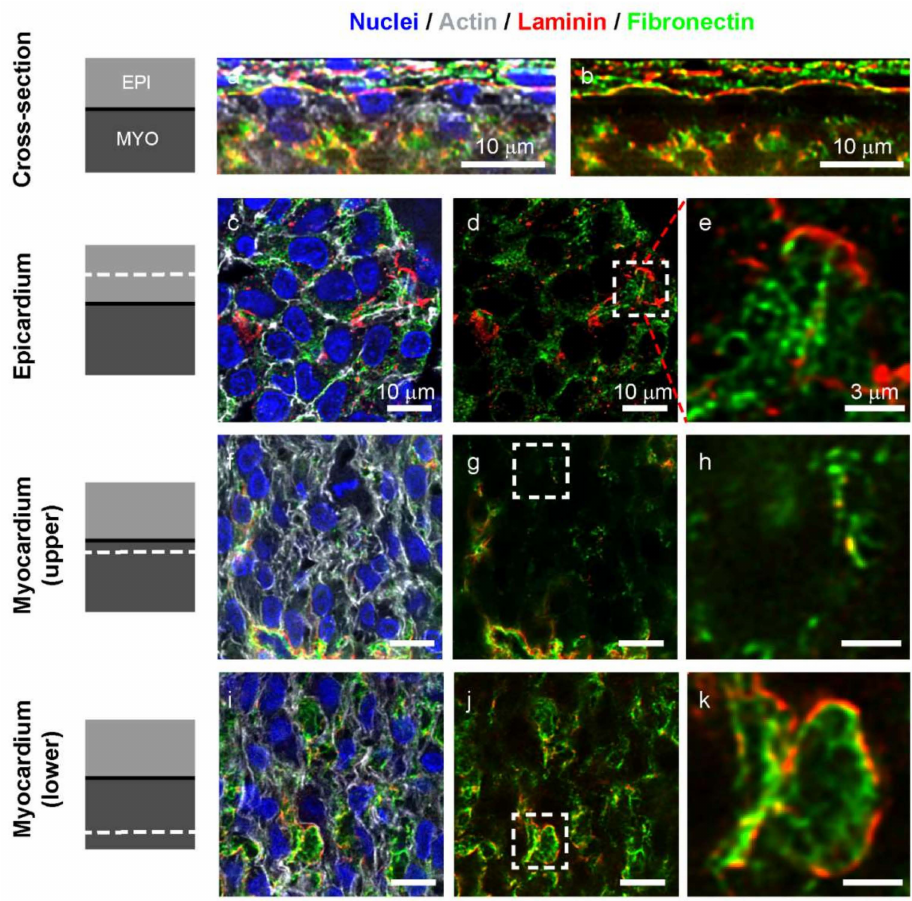
Figure 4. Colocalization of fibronectin and laminin in the myocardium of the left ventricle at day 5. ( a , b ) Cross-sections of a single z-stack of the myocardium of the ventral left ventricle at day 5 stained for nuclei (blue), F-actin (grey), laminin (red), and fibronectin (green). The basement membrane separating the epicardium (top) from the myocardium (below) is well defined and rich in laminin. ( c , d ) Image of a single slice of the z-stack in the epicardium showing epicardial cells lying on a mat of fibronectin fibers with sheet-like laminin. ( e ) Zoomed in image of the area marked by dashed white square in ( d ) revealing the interconnected fibronectin and laminin in the epicardium. ( f , g , h ) In the upper and compacted myocardium, only sparse fibronectin fibers, dotted with punctate laminin are found. ( i , j ) Deeper in the myocardium, acellular cavities are found with no F-actin signal but rich in ECM. ( k ) These intercellular spaces are covered by laminin and filled with fibronectin fibers. Scale bars are 10 µ m for ( a , b , c , d , f , g , i , j ) and 3 µ m for ( e , h , k